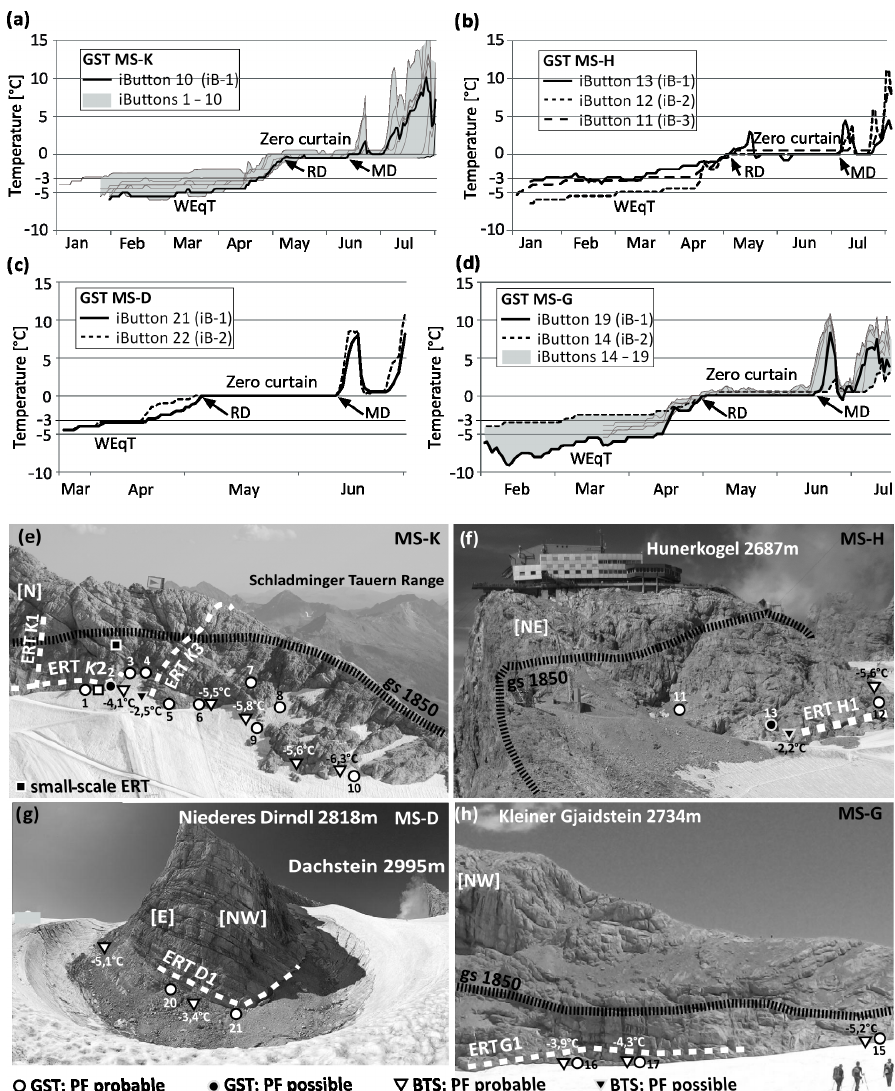
Figure 5. (a–d) GST measurements from January to July 2013. (e–h) Measurement locations of the different techniques at the studied rock walls including interpretation of results of the GST and BTS measurements. The position of the glacier surface (gs) during the maximum of the LIA is indicated at MS-K, MS-H and MS-G (hatched black line). The dashed white lines mark the ERT profiles. GTS locations